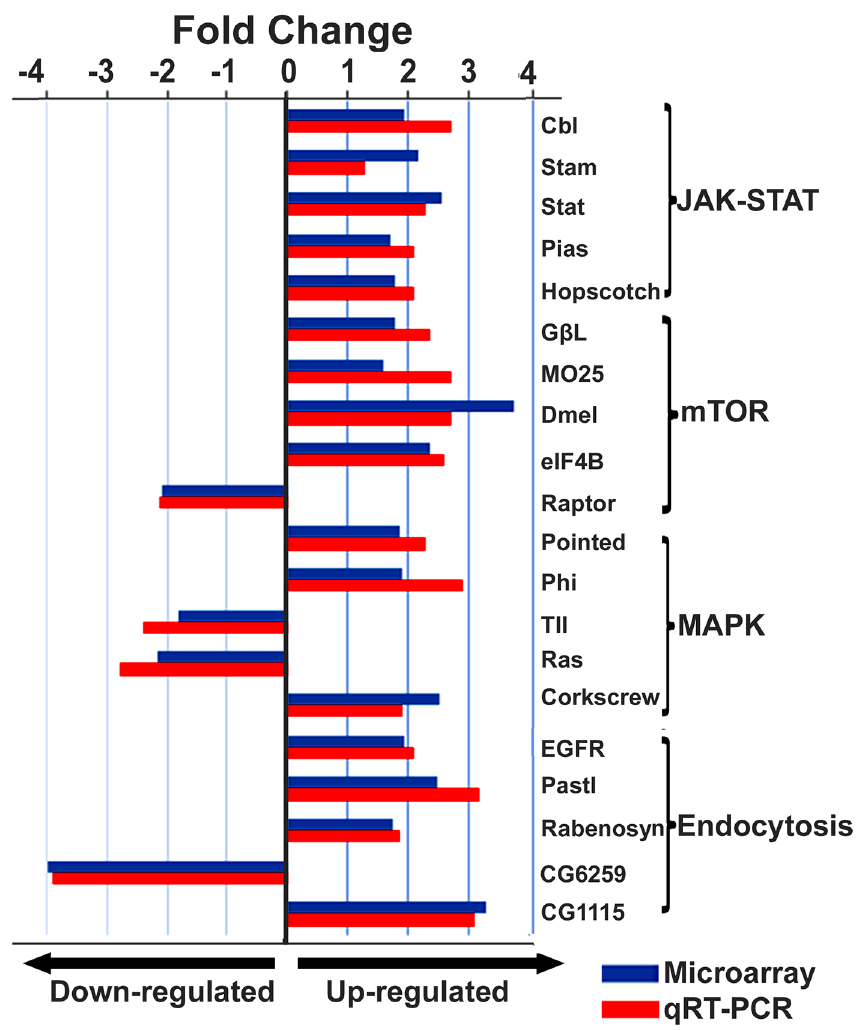
Figure 7. Expression levels of immune-related transcripts in IAPV infected adults. The expression levels of genes that were assigned to JAK-STAT, mTOR, MAPK and Endocytosis pathways were measured by microarray analysis and further confirmed using TaqMan RT-qPCR. The expression results obtained from microarray and qRT-PCR analyses showed good alignment.